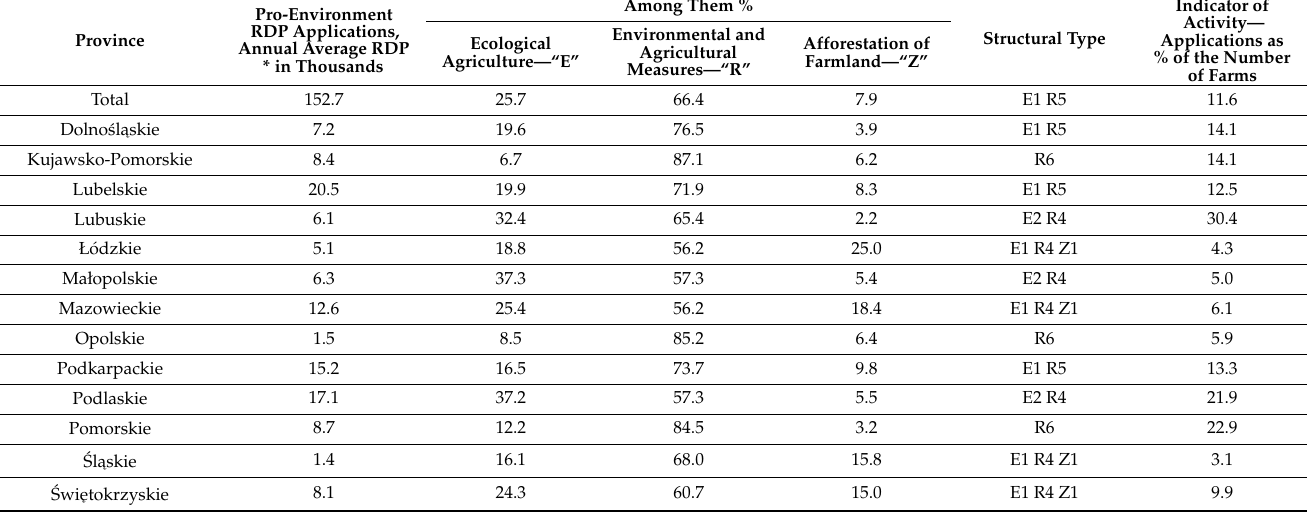
Table 4. Pro-environment RDP applications—regional diversity, level, and